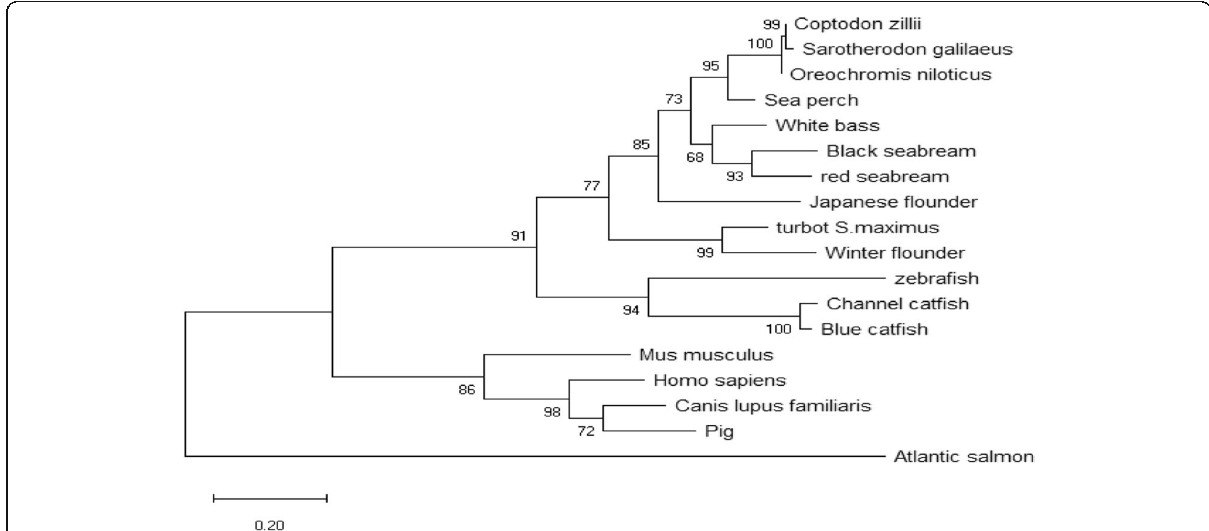
Fig. 9 Phylogenetic analysis of O. niloticus , T. zillii , S. galilaeus hepcidin 2 gene and other species. Constructions are formed on the basis of the homology sequences calculated from the complete amino acid sequence of hepcidin genes. The tree is constructed using a neighbor-joining method. The scale is 0.20 which refers to percentage of